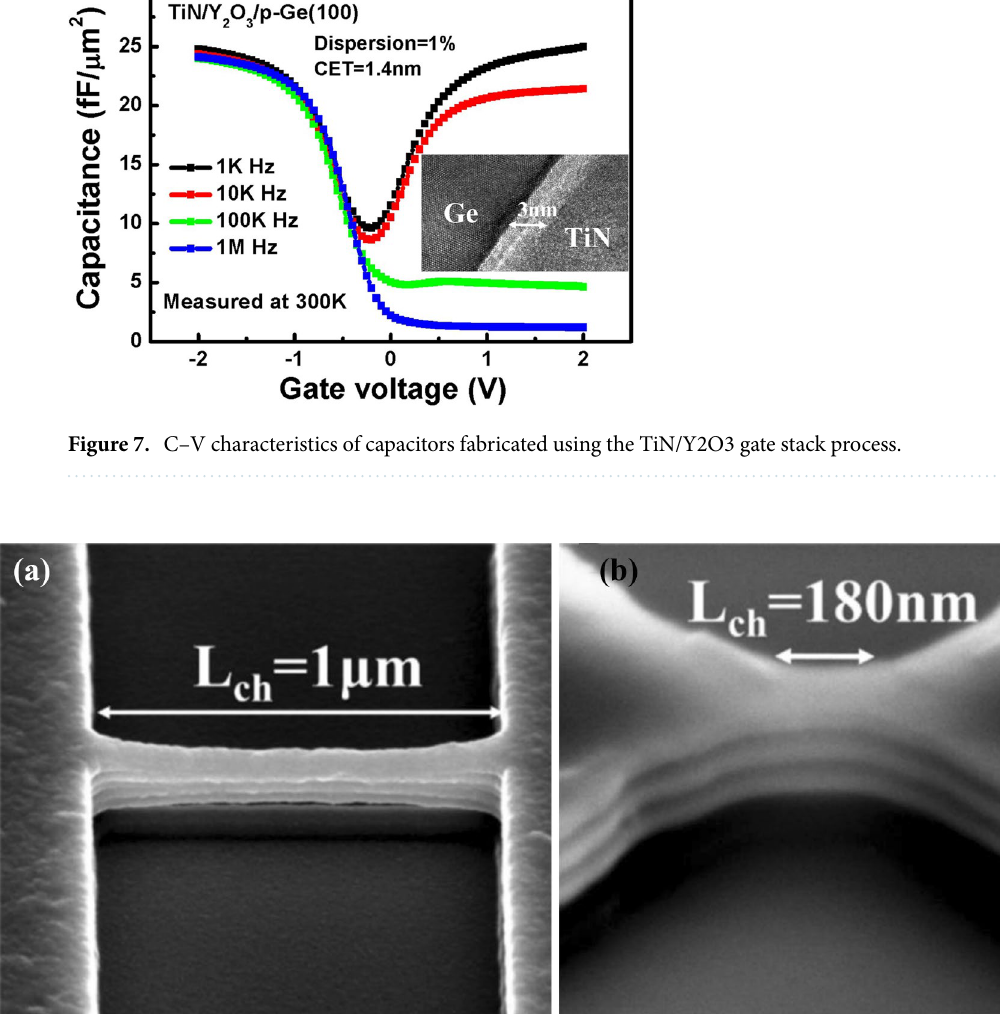
Figure 8. SEM tilting-view images of the stacked Ge nanosheets: ( a ) long structure of 1.0 μm and (b) short structure of 180